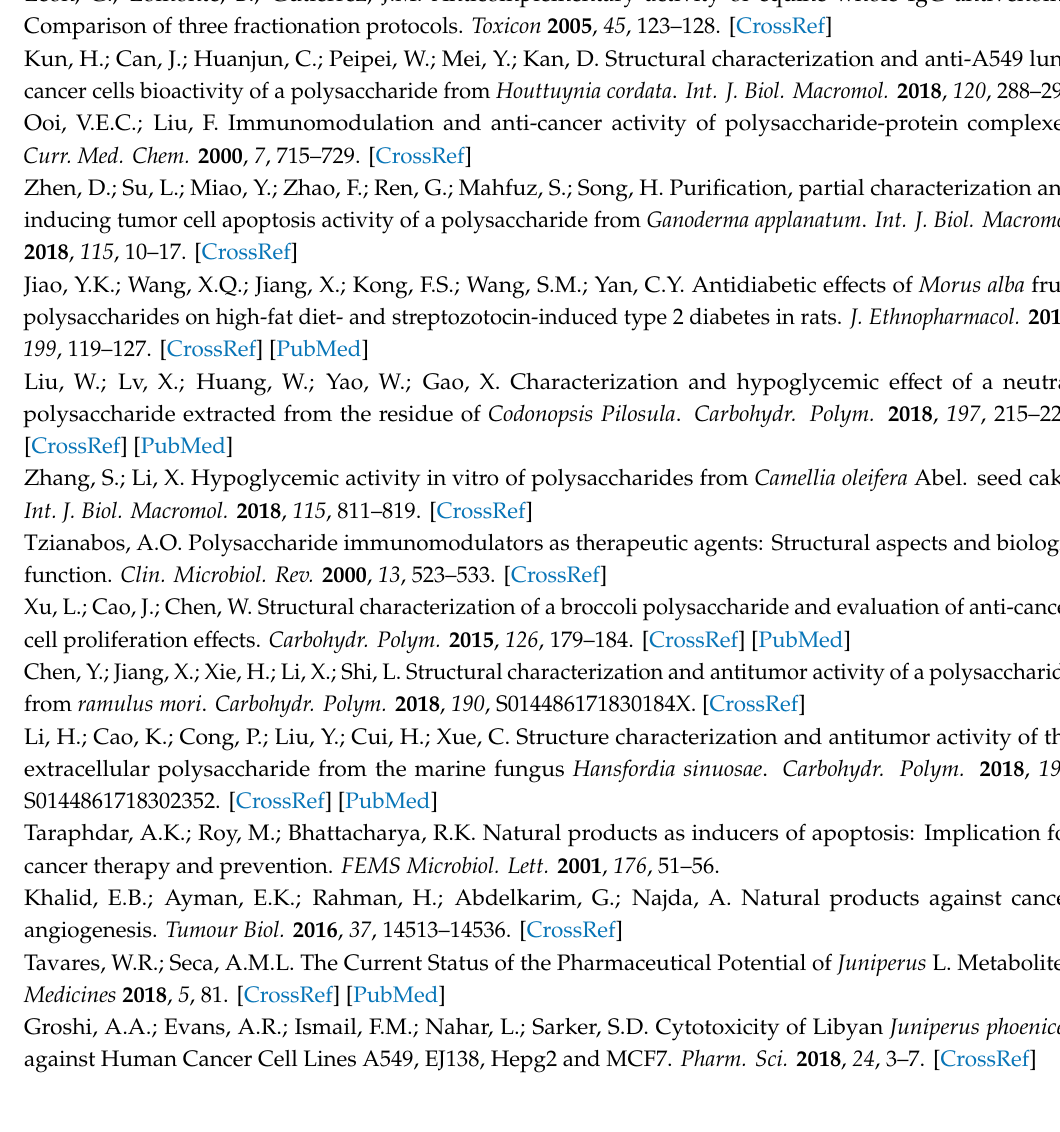
Supplementary Materials: The following are available online, Figure S1: The IR spectrum of JC-PS1, Figure S2: 1 H- 1 H COSY spectrum of JC-PS1, Figure S3: Cytotoxicity of JC-PS1 on RAW264.7 cells. Figure S4: The repeating unit of JC-PS2. Table S1: Alditol acetate derivatives from the methylated